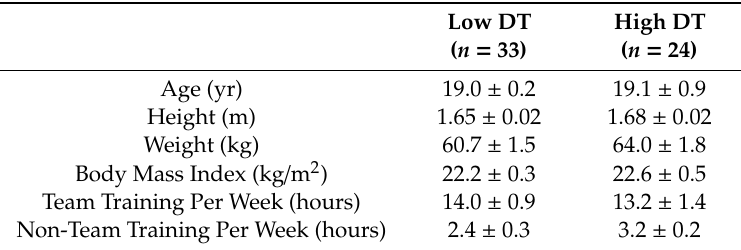
Table 2. Demographic and the training characteristics of the women with a low drive for thinness and a high drive for thinness.